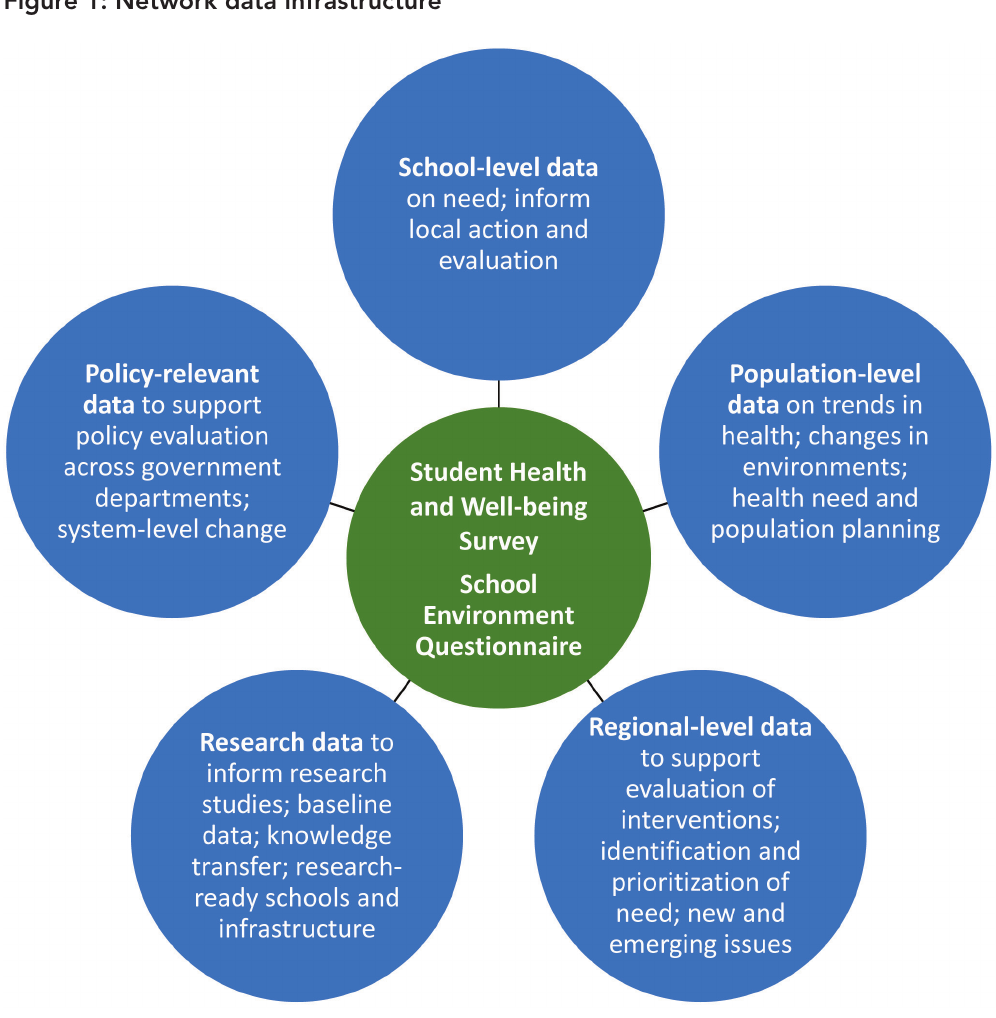
Figure 1: Network data